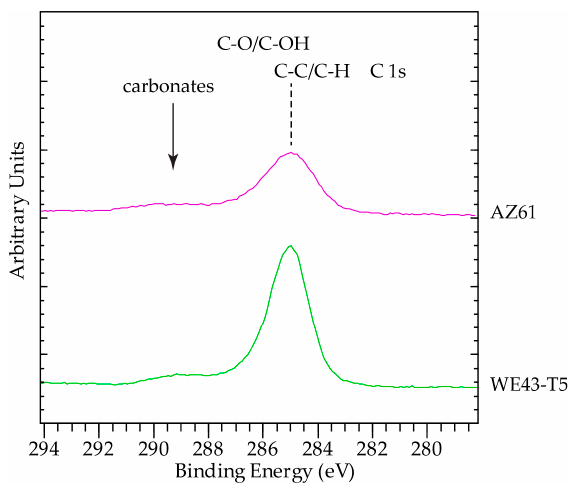
Figure 14. C 1s peak. The spectra were calibrated for charging by setting the C 1s peak maximum at 285 eV.